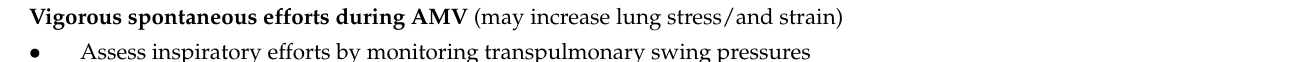
Table 2. Important points to consider during assisted mechanical